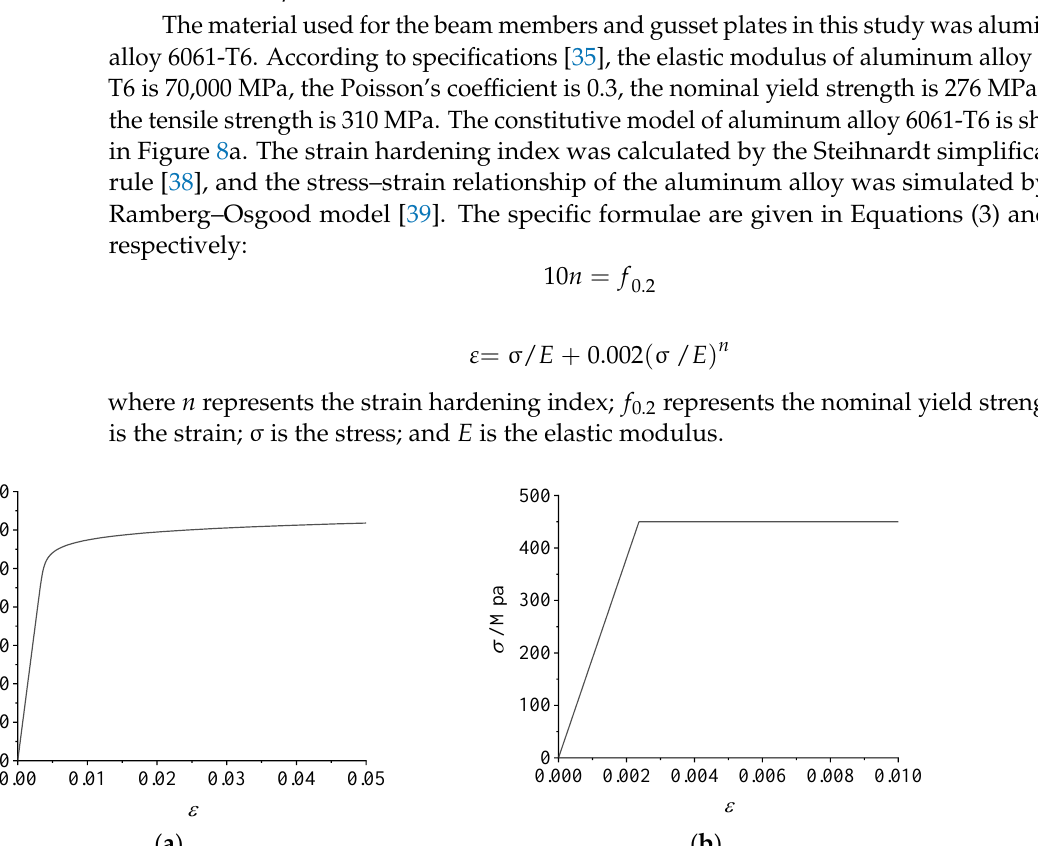
( b ) Figure 9. Comparison between theoretical model and FE model. ( a ) Full model; ( b ) quarter model. To reduce the calculation cost and time, according to the force and geometric sym- metry, the full model of the AAG joint was simplified, and the quarter FE model is shown in Figure 9b. In the quarter model, fixed constraints were first imposed at the center of the joint plate, and symmetric constraints were imposed on the plate section. Second, a refer- ence point for coupling to the member end section was defined, and displacement loads were applied to this reference point. The numerical simulation was carried out based on the quarter FE model. 4. Flexural Performance of AAG Joints To preliminarily investigate the flexural performance of AAG joints, benchmark model J (350-10-275-12-0.3) was analyzed, and its failure mode, deformation process, and bending moment-rotation curves were obtained. 4.1. Failure Mode Figure 10 illustrates the failure mode of the benchmark AAG joint model. When the joint was damaged, the maximum stress of the member was mainly concentrated at the outer row of bolt holes on both sides of the flange along the displacement load direction, the maximum stress of the joint plate was concentrated in the central area of the joint plate,